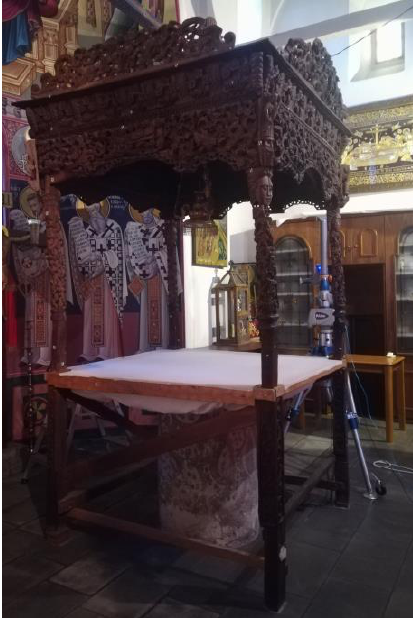
Fig.1 The ecclesiastical ciborium (17 th